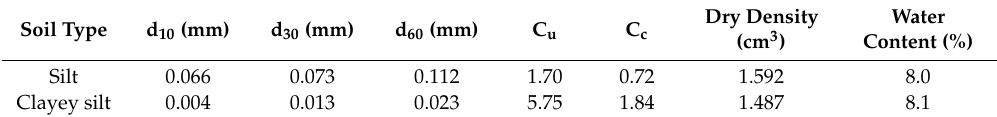
Table 3. Parameters of raw soil.